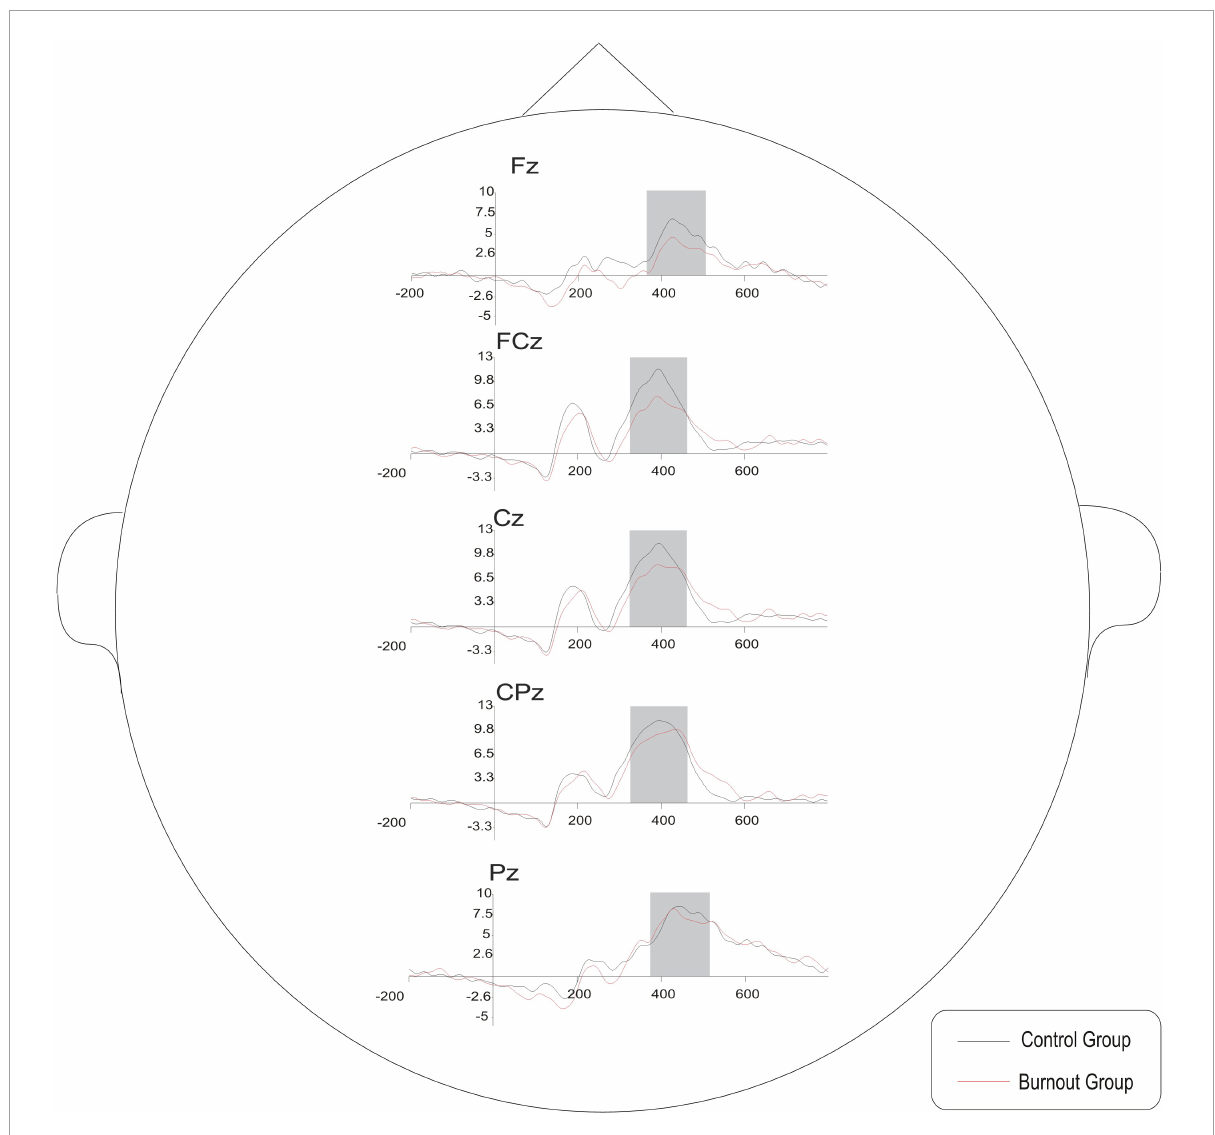
FIGURE6 The average P3b waveforms of the five electrode sites in the burnout group and control group in the oddball